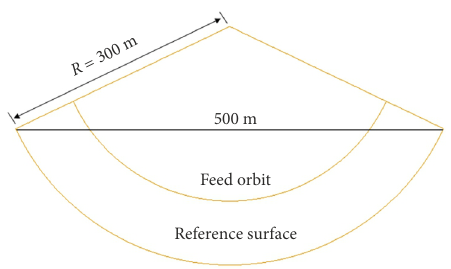
Feed orbit Reference Figure 2. Reference surface of the cable-net structure